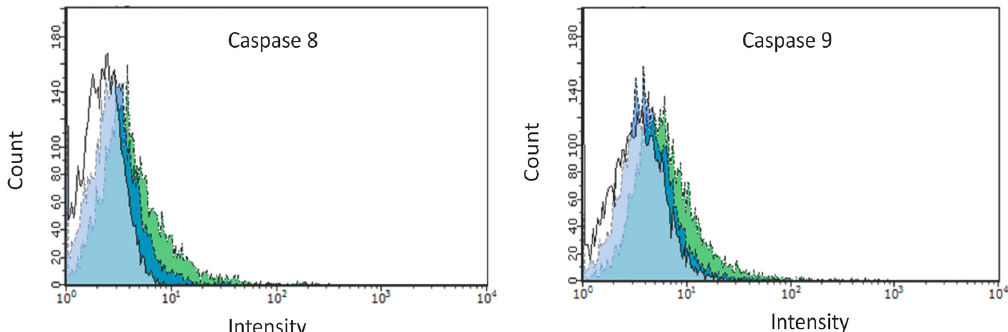
Figure 4. Activated caspase-8 and -9 positive cells were analyzed by flow cytometry at 3 days post transfection. Representative histogram showing the increase in caspase-8 and -9 staining in mutPKR (blue) and wtPKR (green) transfected cells relative to non-transfected control cells (white, in front).